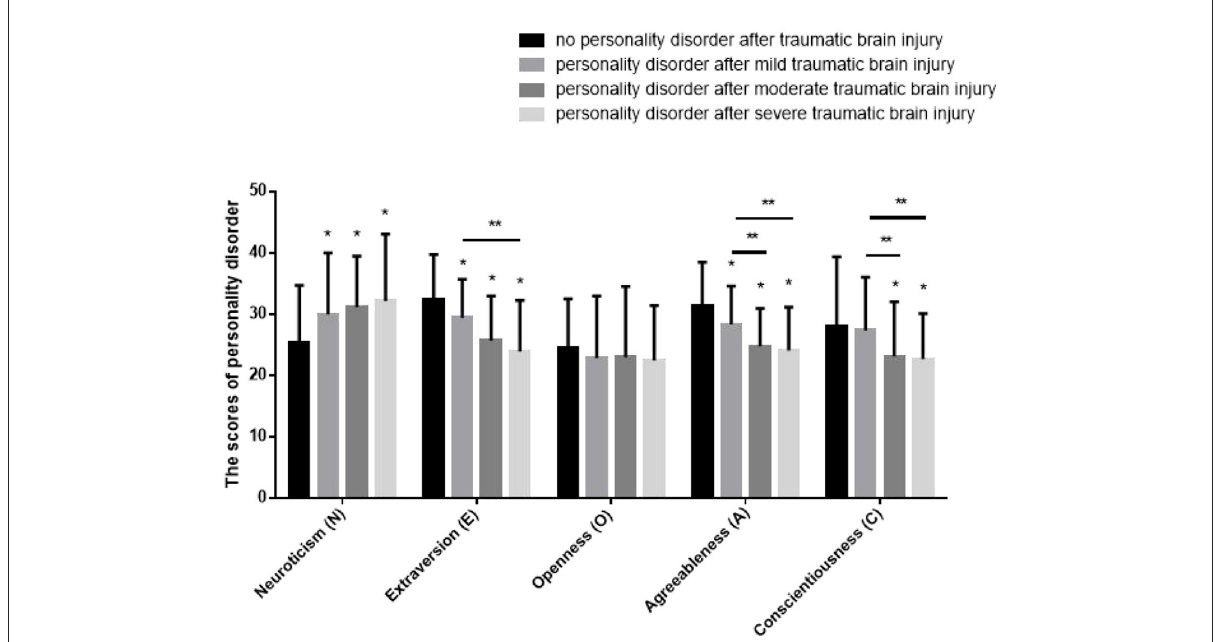
FIGURE3 The scores in five dimensions of personality disorder. * Compared with people without personality disorder, P < 0.05. ** Compared with people with personality disorder after mild traumatic brain injury, P < 0.05. The scores in neuroticism dimension of people with personality disorder after TBI were significantly higher than that of people without personality disorder. The scores in extraversion dimension of people with personality disorder after TBI were significantly lower than that of people without personality disorder. The scores in agreeableness dimension of people with personality disorder after TBI were significantly lower than that of people without personality disorder. The scores in conscientiousness dimension of people with personality disorder after moderate and severe TBI were significantly lower than that of people with personality disorder after mild TBI and without personality